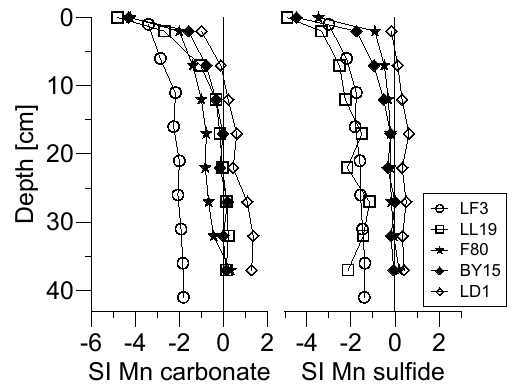
Figure 3. Saturation indices (SI) for Mn carbonate (here as Mn 0 . 74 Ca 0 . 26 CO 3 ) and Mn sulfide as calculated from the pore wa- ter data with